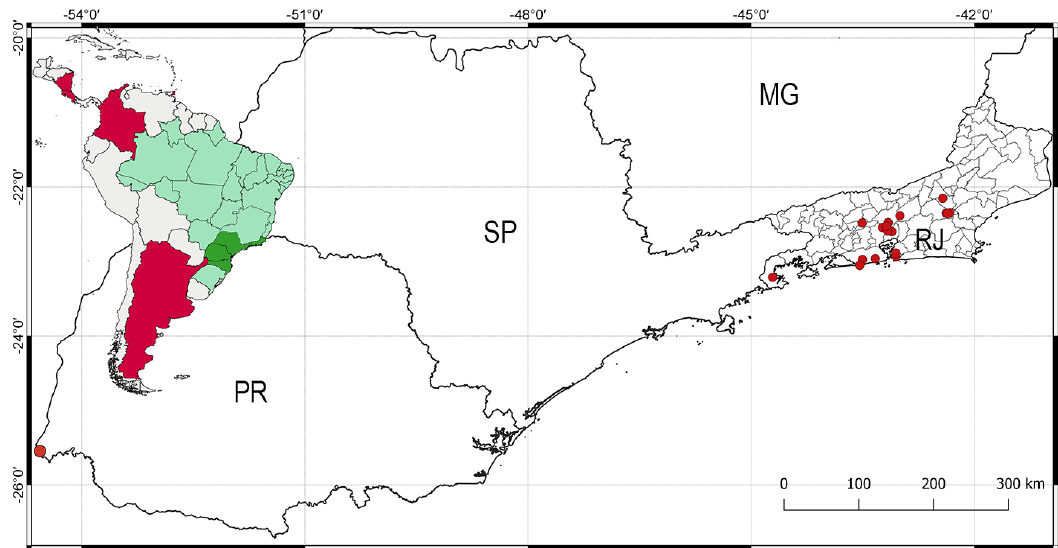
Figure 2. Distribution of Ovachlamys fulgens in Central America (Nicaragua and Costa Rica), Antilles (Trinidad and Tobago) and South America (Colombia, Argentina and Brazil). Brazil is in light green and States where the species has been reported are in dark green (considering previous reports and the present study). Red circles represent the new occurrences of O. fulgens in Rio de Janeiro and Paraná State,